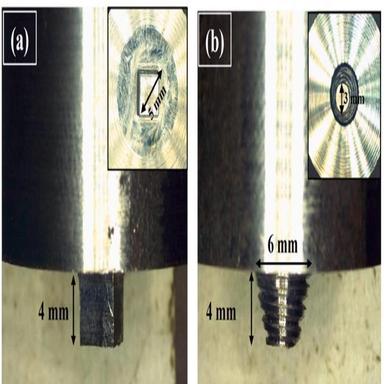
FSP tools used in the current study: (a) Square pin profile (b) Taper threaded pin profile.